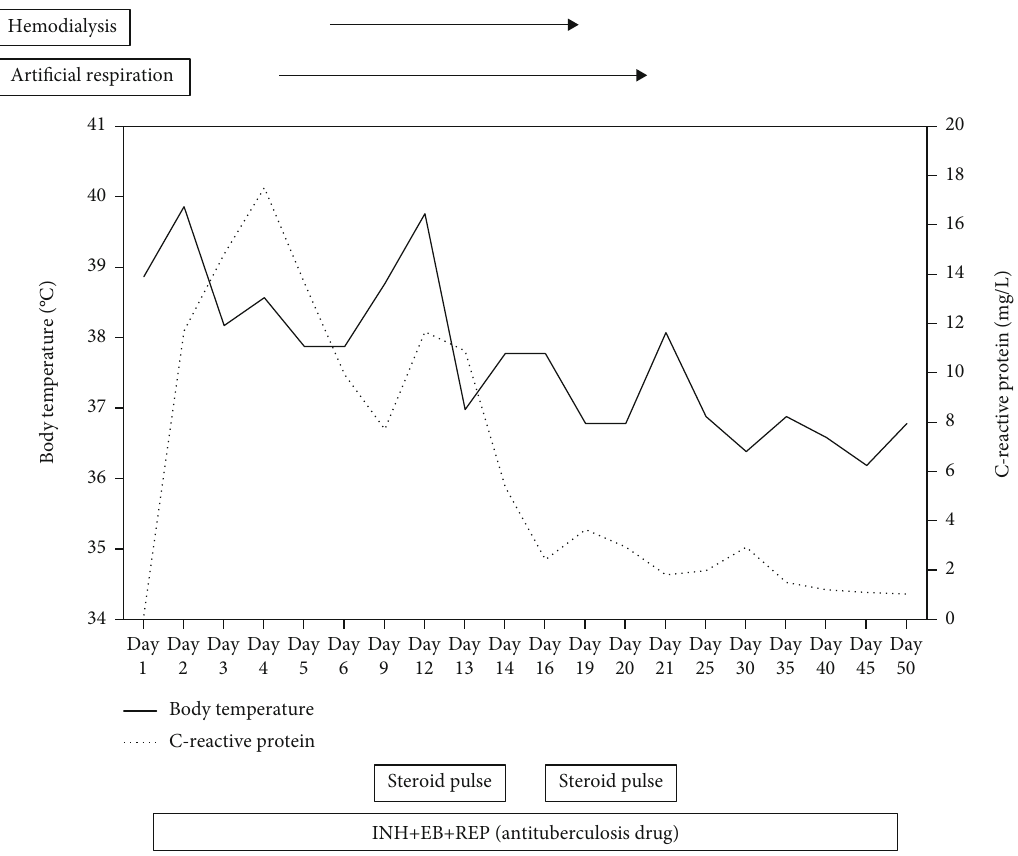
Figure 1: Treatment course of the patient with Bacillus Calmette-Guérin (case 5). EB =ethambutol; INH =isoniazid; REP